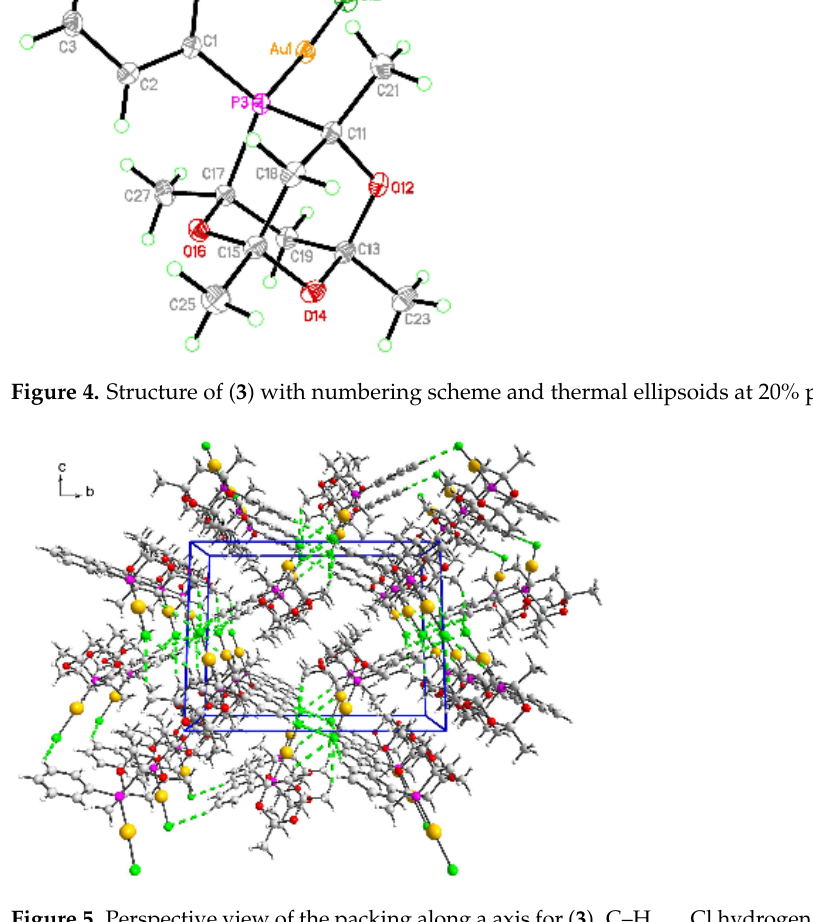
Figure 5. Perspective view of the packing along a axis for ( 3 ). C–H…Cl hydrogen bonds are marked by dotted green lines.